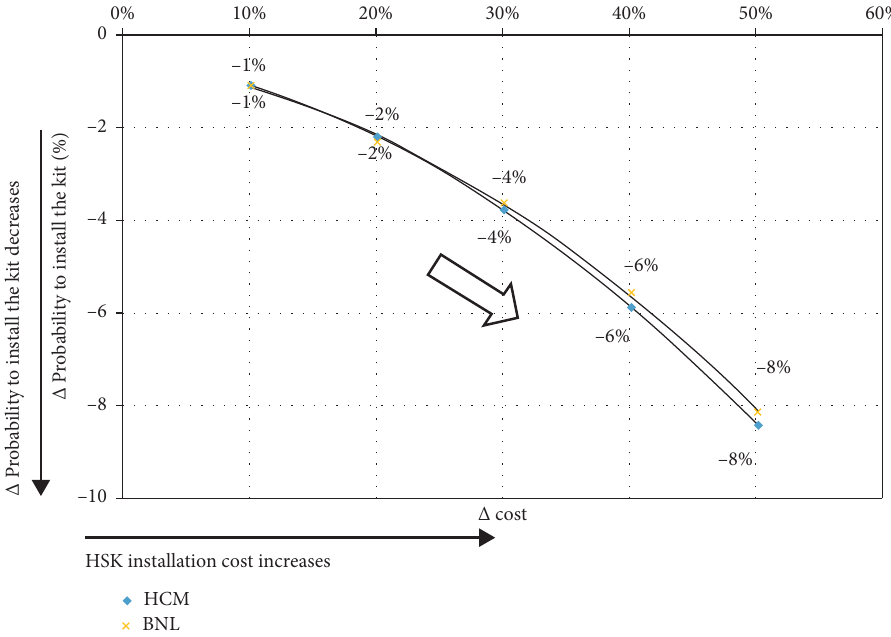
Figure 3: BNL/HCM: sensitivity analysis of Δ Probability of choice to install against Δ